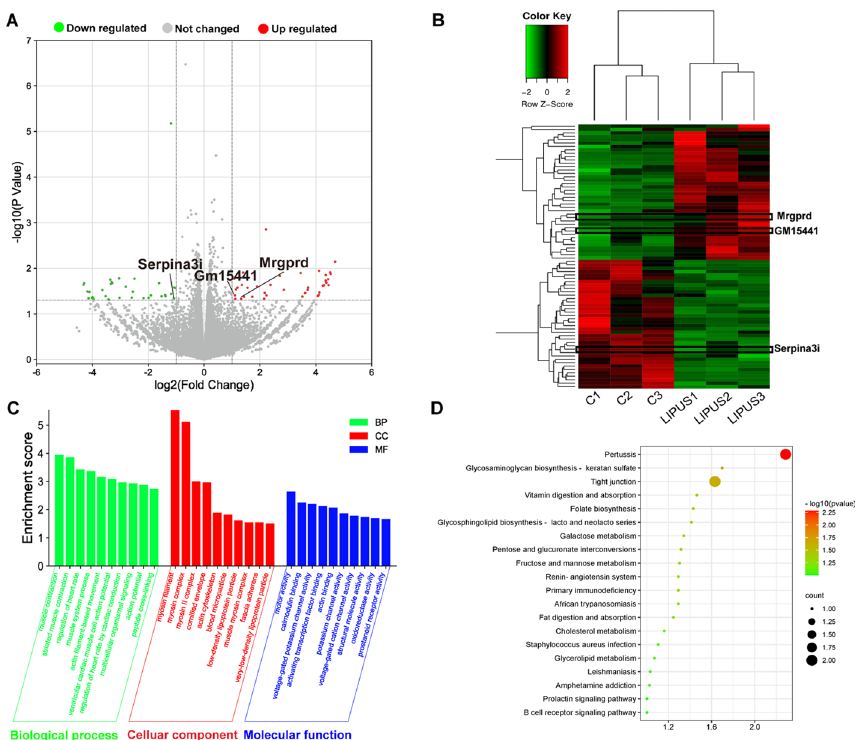
Fig. 4 Analysis of differentially expressed genes between C-BMSCs and LIPUS-BMSCs with functional annotation and classification. A Volcano map of DEGs between C-BMSCs and LIPUS-BMSCs. The x -axis is the log2 scale of the fold change of gene expression in MSCs and induced ECs (log2(fold change)). Negative values indicate downregulation; positive values indicate upregulation. The y -axis is the minus log10 scale of the adjusted p values ( log10 ( p value)), which indicate the significant level of expression difference. The red − dots represent significantly upregulated genes with at least twofold change, while the green dots represent significantly downregulated genes with at least twofold change. B Heatmap of the DEGs between C-BMSCs and LIPUS-BMSCs. Red stripes in the Figure represent high expression genes, while green stripes represent low expression genes. C Significant enriched GO terms between C-BMSCs and LIPUS-BMSCs based on their functions. D The top 20 enriched KEGG pathway terms of